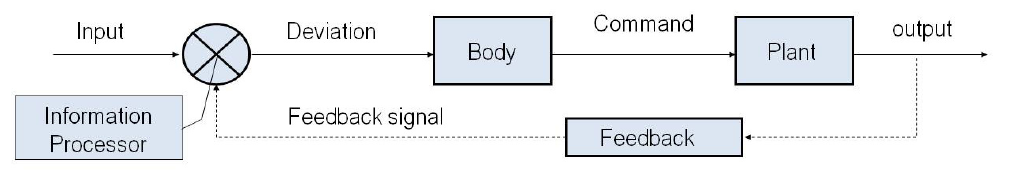
Figure 2. Closed-loop control process